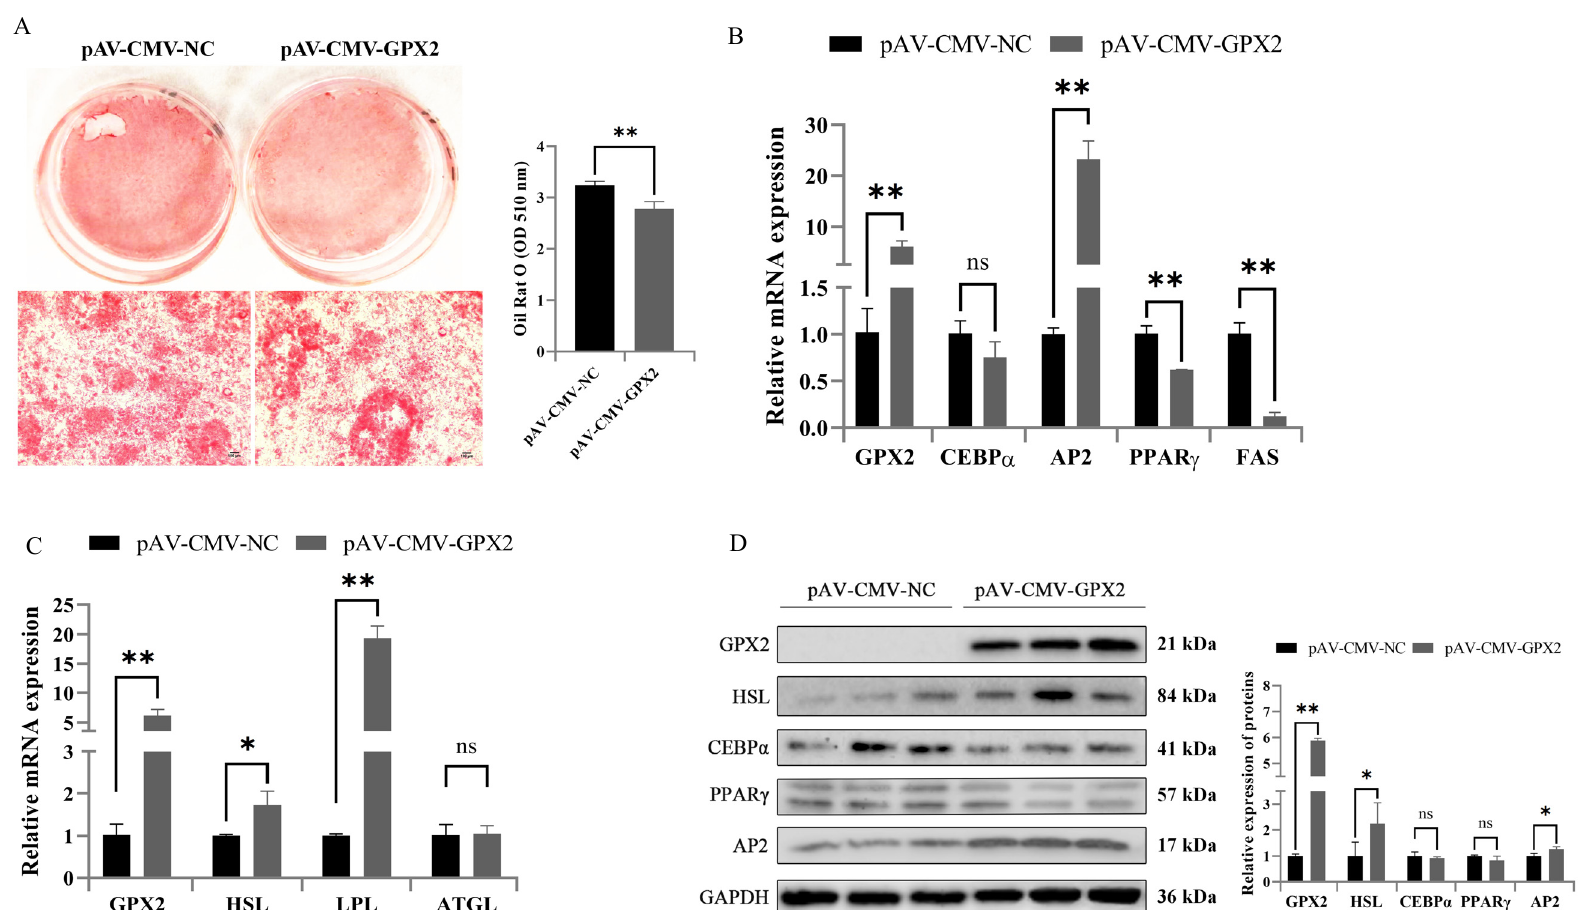
Figure 5. Overexpression of GPX2 inhibited adipogenic differentiation and promoted the lipid degradation of 3T3-L1. ( A ) Photograph and micrographs of 3T3-L1 stained with Oil red O, extraction and detection of lipid contents from negative control and overexpression of GPX2. ( B ) mRNA expression of adipogenic regulator and ( C ) lipid degradation in negative control and overexpression of GPX2 group of 3T3-L1 after 7 days’ differentiation. ( D ) Protein expressions and abundance analysis for adipogenic regulator and lipid degradation in 3T3-L1 after 7 days’ differentiation from negative control and overexpression of GPX2. * indicates p < 0.05, ** indicates p < 0.01, ns indicates not significant.